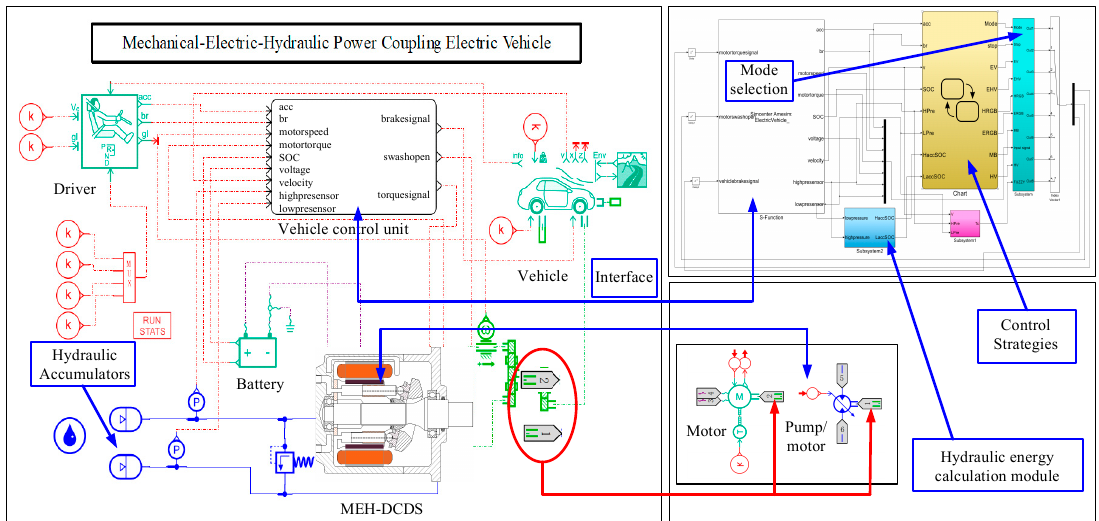
Figure 14. Model drawing of the whole car.